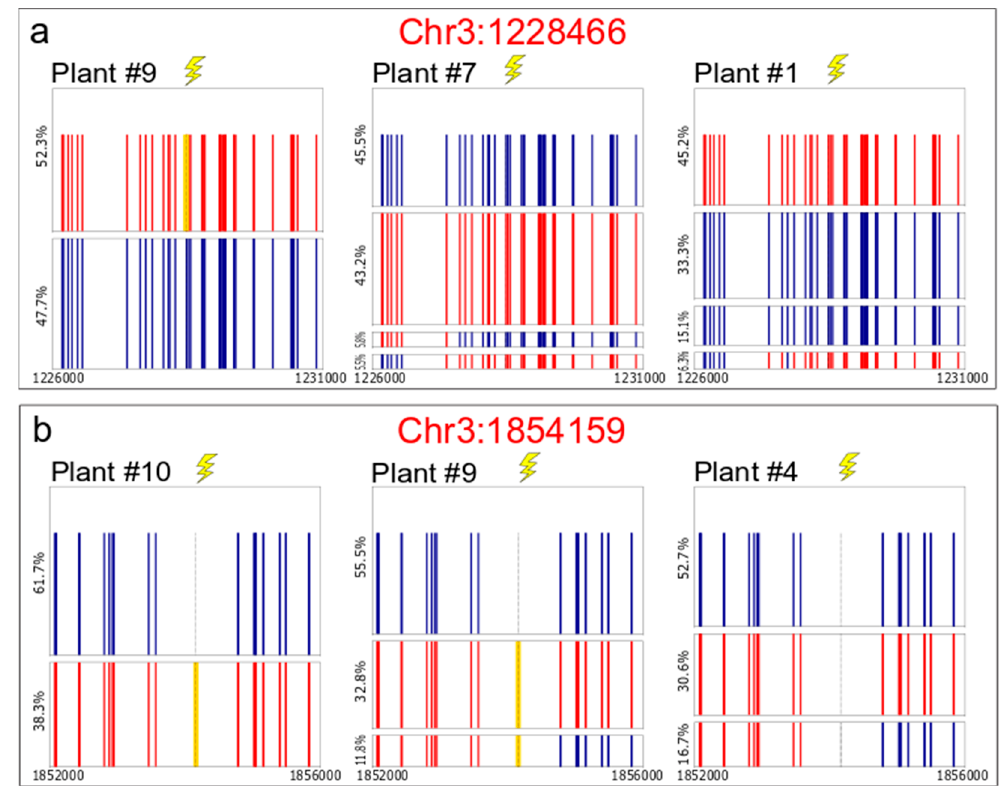
Figure 3. Somatic HR based repair- Distribution of parental, mutant, and recombinant alleles in Ler x Col background enables measurement and characterization of somatic DNA DSB repair events—allelic distribution resulting from somatic DSB repair, determined through PacBio ® sequencing of F1 plants from ( a ) the Ler x (Col Ubi:Cas9 x U6-26:Chr3:1228466), and ( b ) the Ler x (Col Ubi:Cas9 x U6-26:Chr3:1854159) populations. Every square represents the allelic distribution for each plant sequenced in a window of ~5 Kb flanking the DNA DSB target. In each square, each rectangle represents one consensus sequence calculated by the LAA2 analysis. The height of the rectangle represents the relative frequency of this consensus sequence/allele (percentage of subreads that aligned to calculate the consensus sequence). Red vertical lines represent Columbia SNPs, blue vertical lines represent Landsberg SNPs, the yellow line represents indels at the break site, and the dashed black line with lightning represent the DNA DSB site.